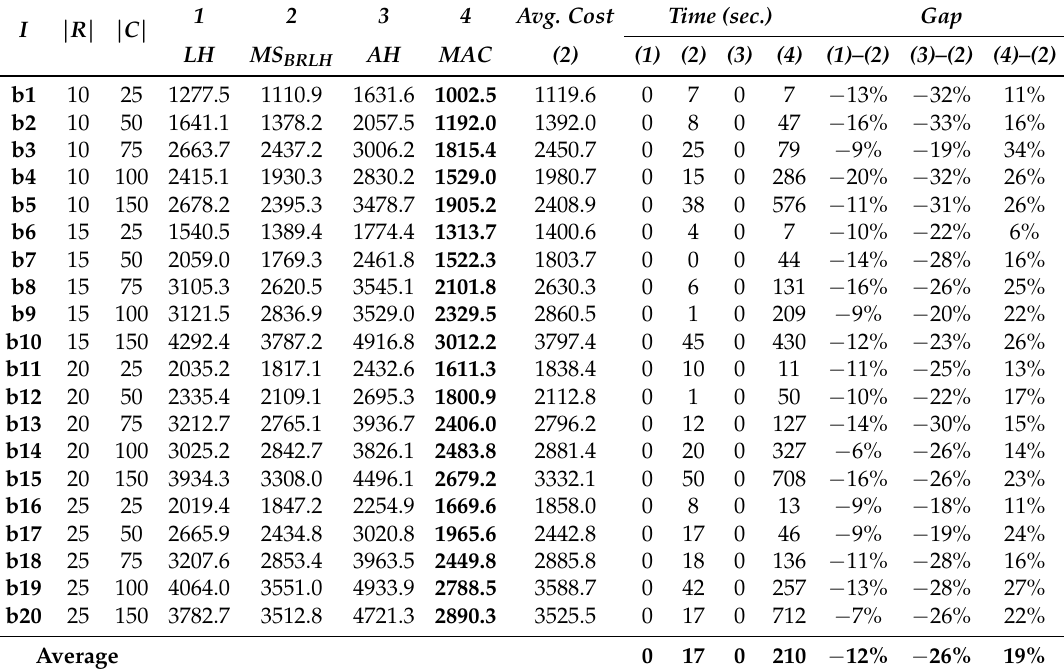
Table 3. Comparison of the results obtained by our methodologies (LH and MS BRLH ) with those obtained by Abdulkader et al. [1]’s methods (AH and MAC) in the tight inventory scenario.